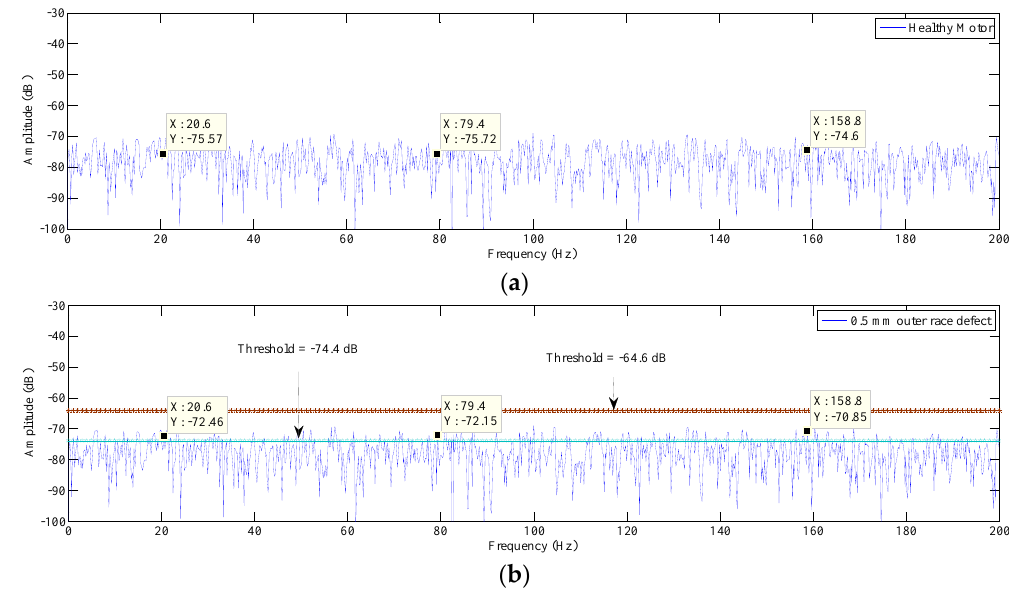
Figure 6. The PV modulus spectrum of the motor under no-load condition at bearing fault frequencies of 20.6 Hz, 79.4 Hz and 158.8 Hz ( a ) Healthy bearing ( b ) Defected bearing.